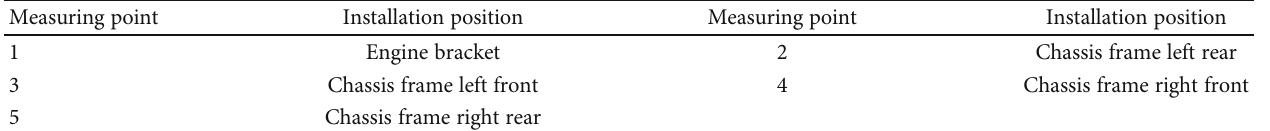
Table 1: Distribution location of vibration measurement points.